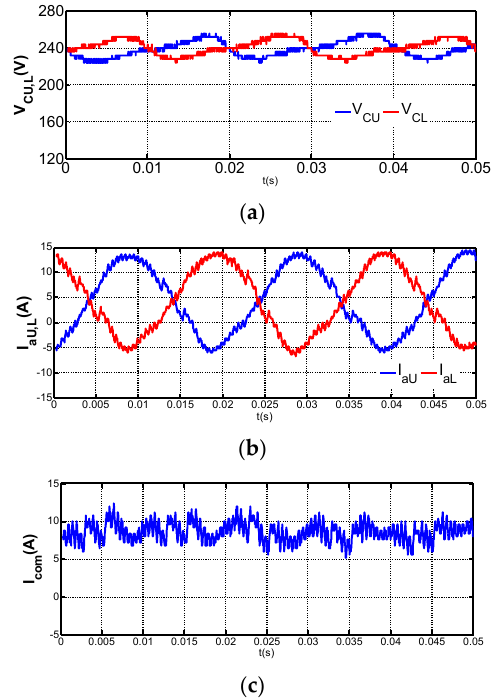
Figure 16. Experimental waveforms of the 3-cell MMC that employs internal Scheme-A: ( a ) upper and lower capacitor voltage sums, ( b ) upper and lower arm currents, and ( c ) common-mode current with the measured fundamental frequency content of 6.6%.